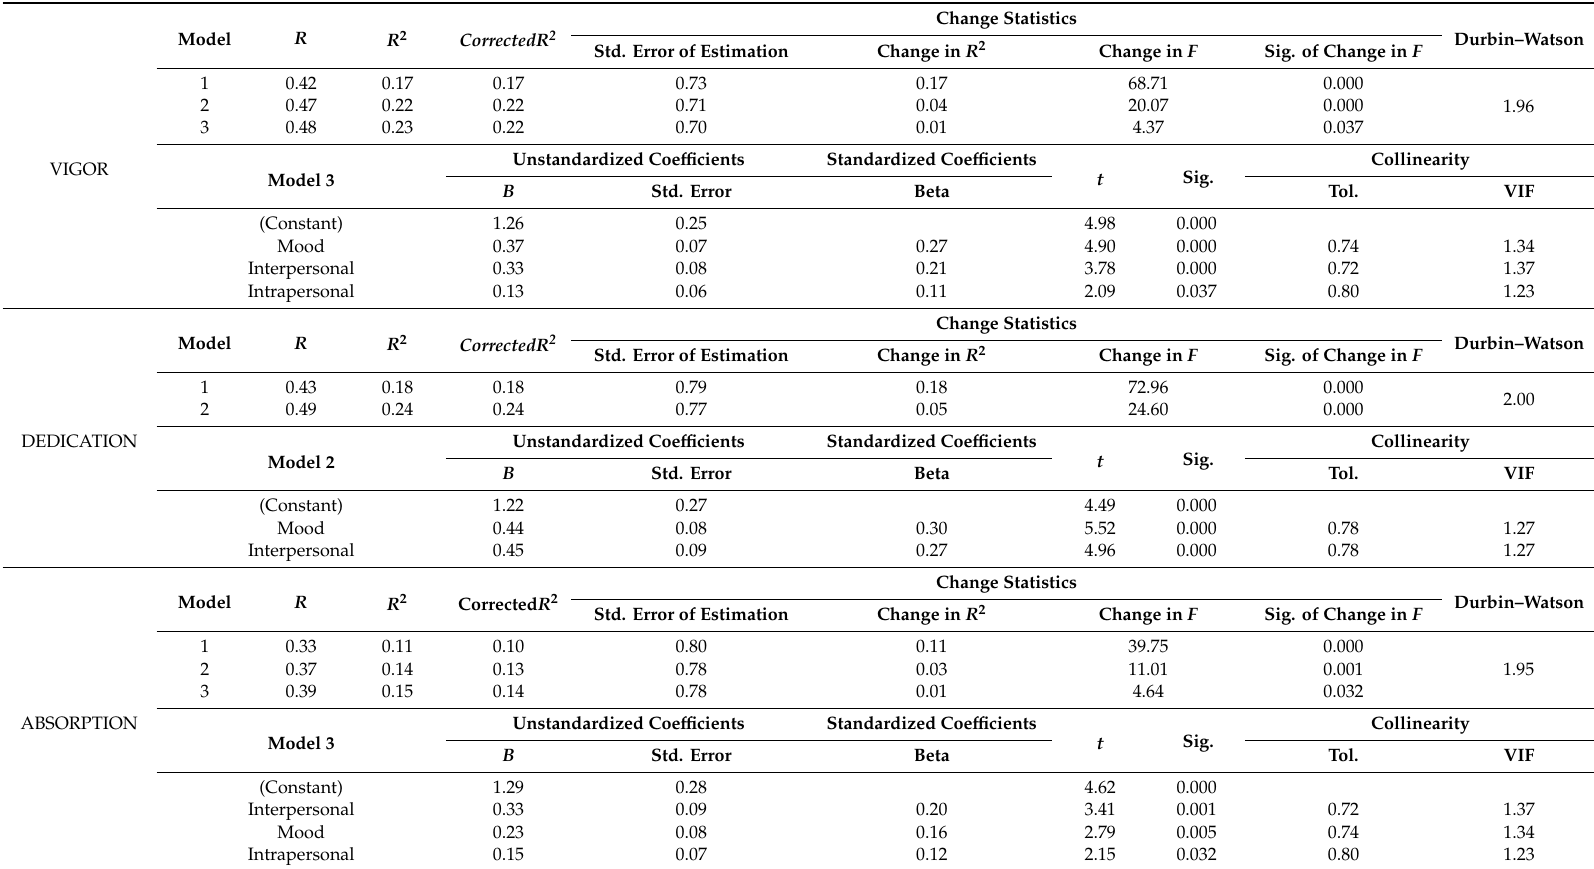
Table 1. Stepwise multiple linear regression model. Vigor, dedication, absorption (men; n =